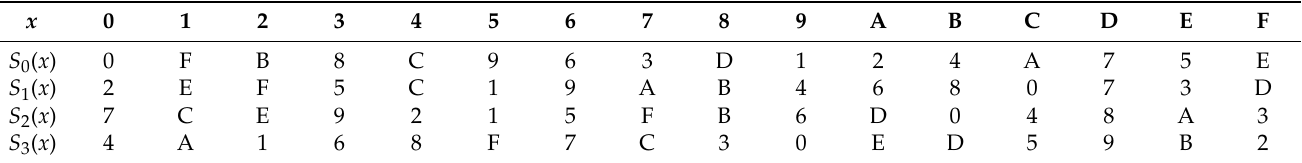
Table 1. Four «golden»